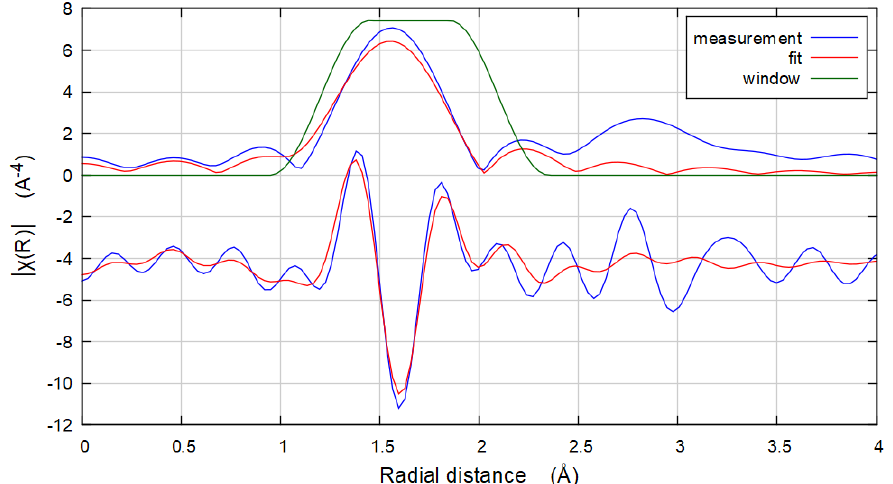
Figure 9. EXAFS fit (magnitude (top) and real part (bottom)) to the Rb 4 Ge 5 O 9 F 6 :Nb specimen with focus on determining first shell bond lengths. Real space data were not plotted with phase shift correction, so bond lengths appear shorter than reported. The refined values indicate the first shell average bond length, fit using one path, is 2.03(4) Å. The refined Debye-Waller factor is 0.003(2)A2, with a refinement R factor of 0.03 with reduced chi-squared of 3459.